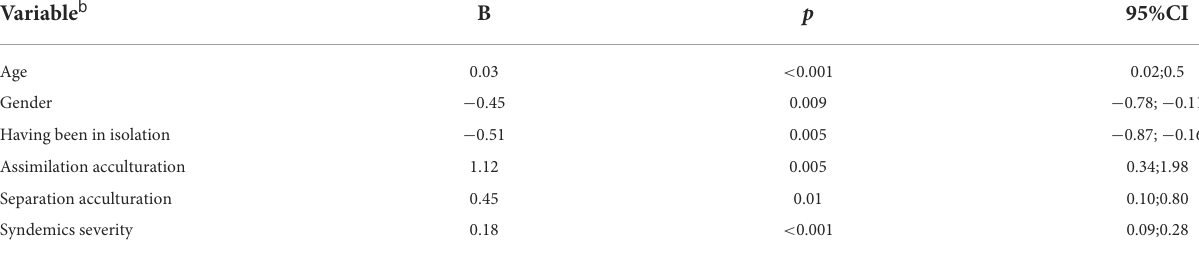
TABLE 3 Linear regression a (stepwise method) to explain adherence to recommended COVID-19